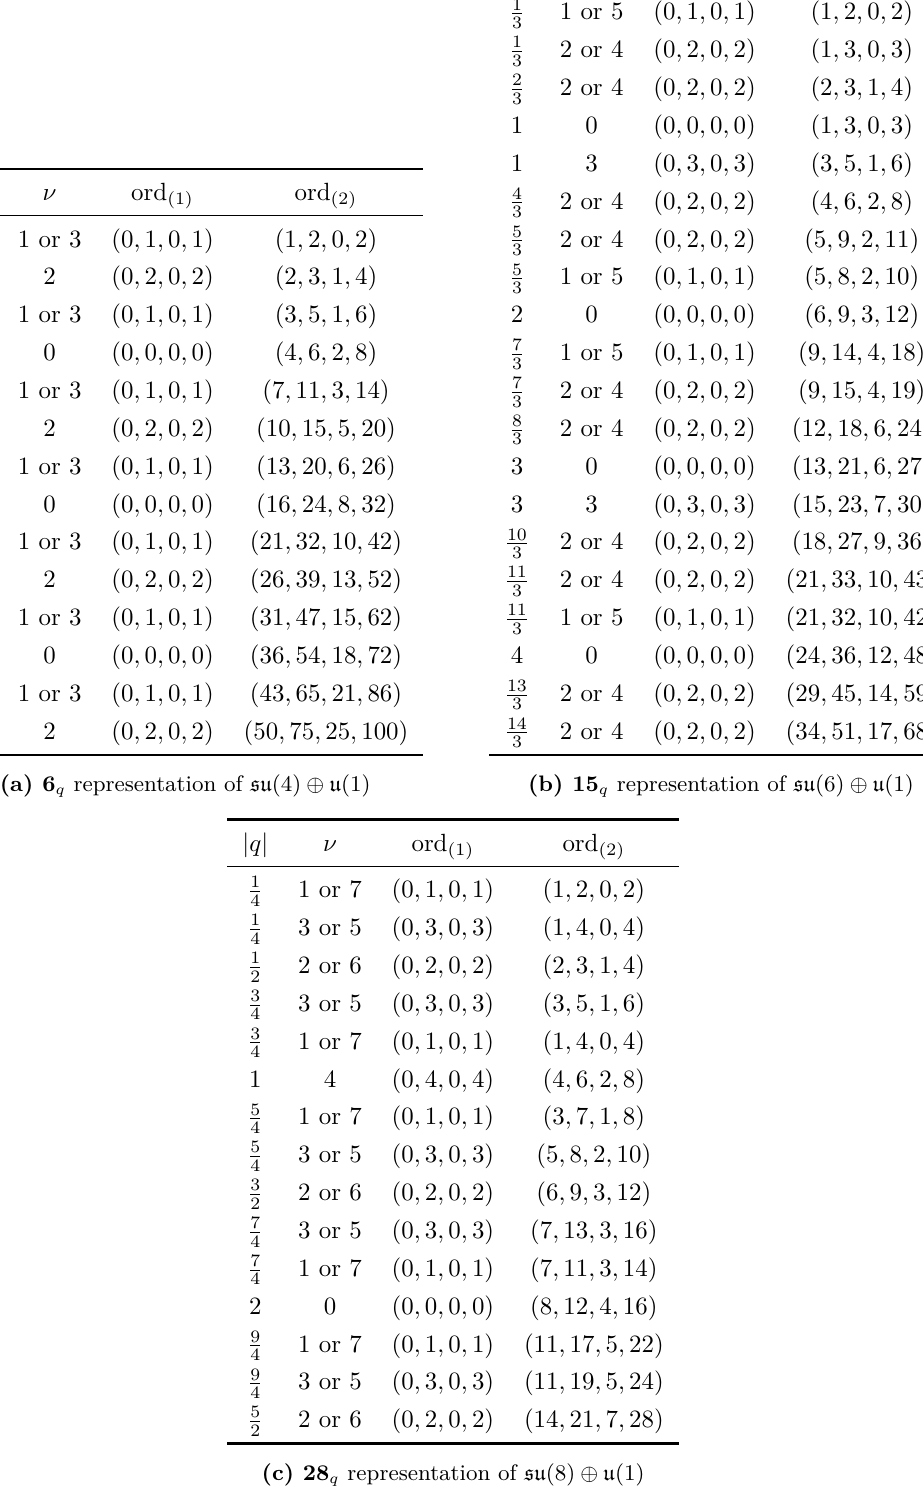
Table 13. Orders of vanishing of (ˆ x, ˆ y, ˆ z, ˆ w ) or various combinations of ν and pseudo-charge q for antisymmetric matter of su (2 k ) ⊕ u (1)